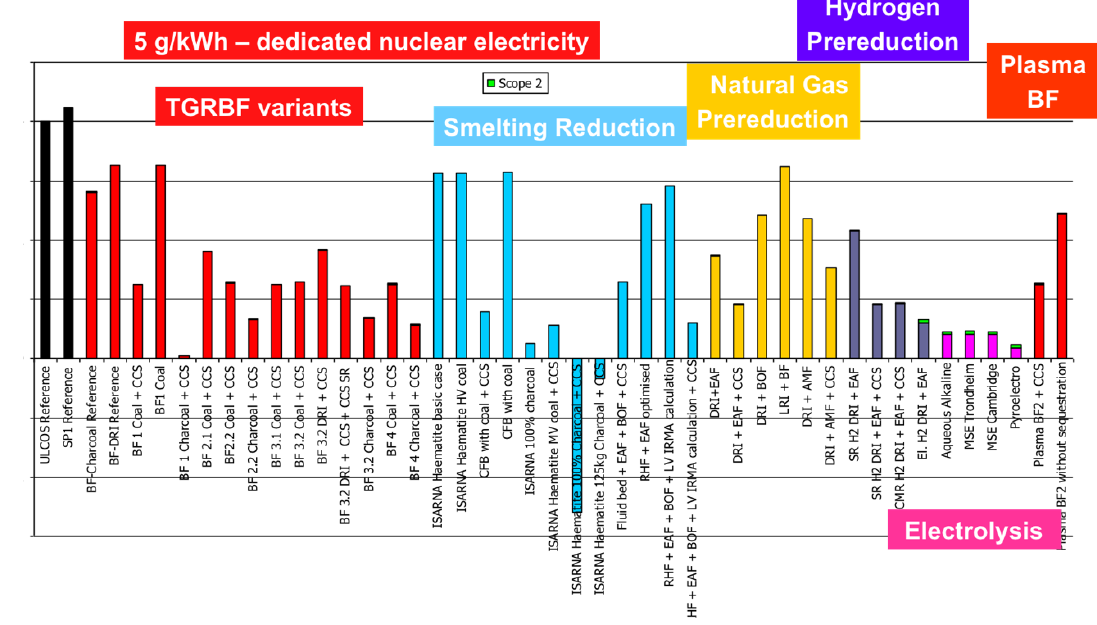
Figure 20. CO 2 specific emissions (t CO2 /t HRC ) for a 5 g/kWh grid.